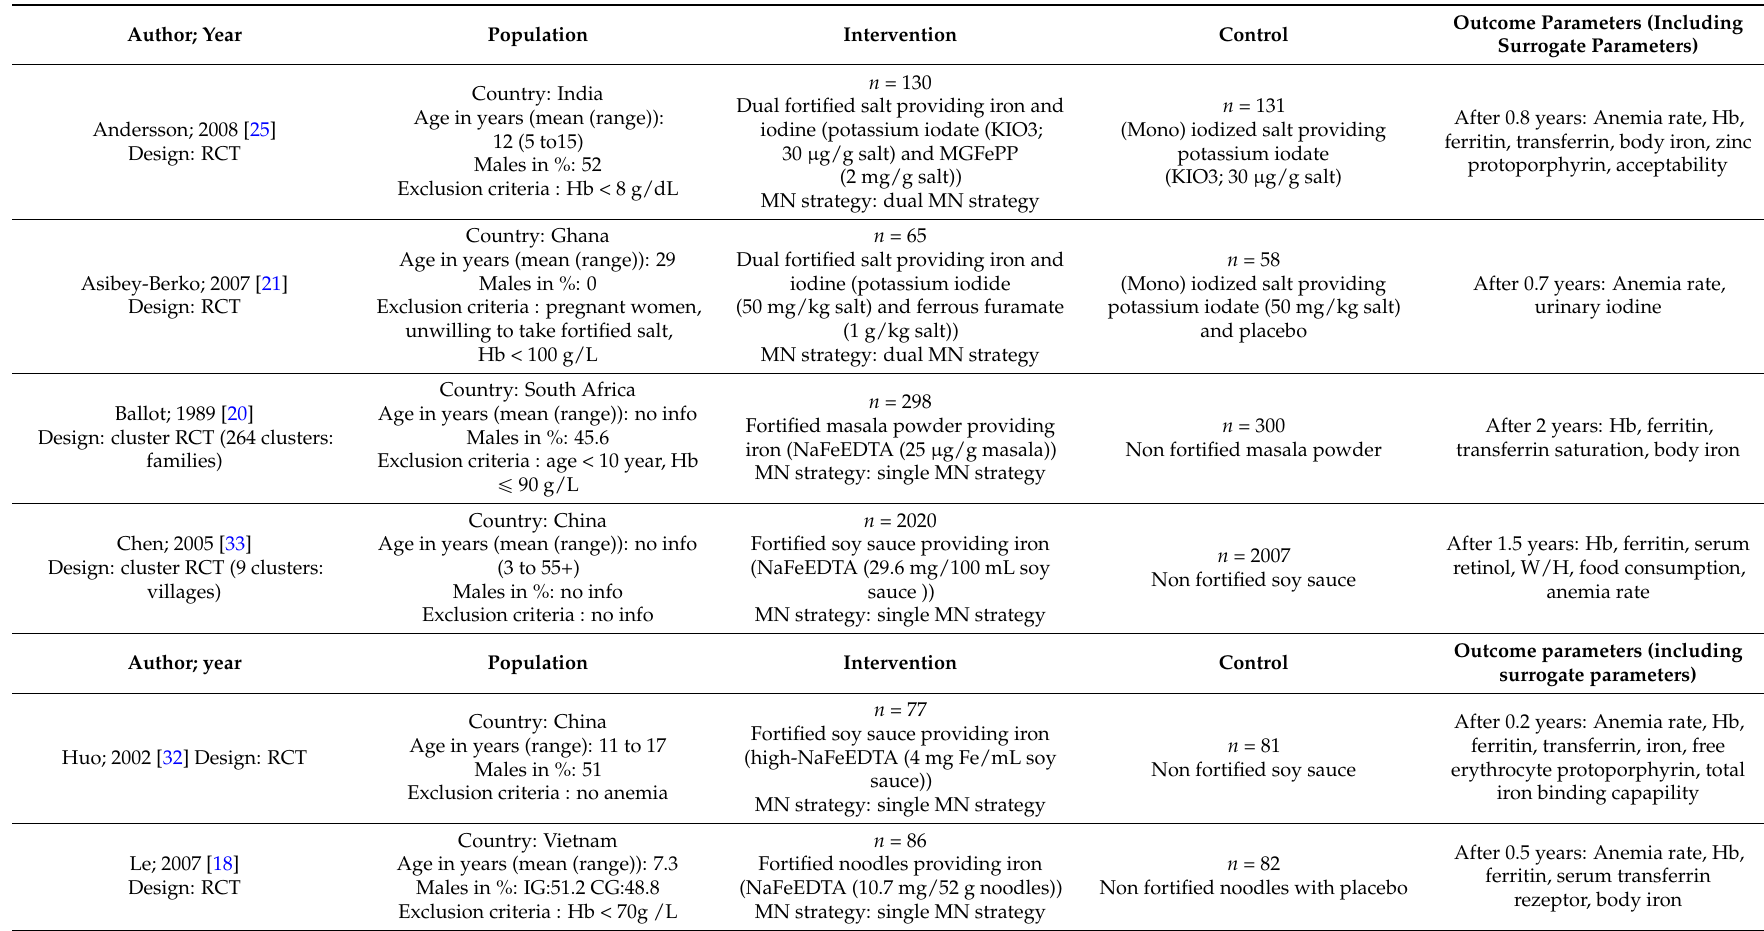
Table 2. Details of included RCT studies for micronutrient fortified condiments and